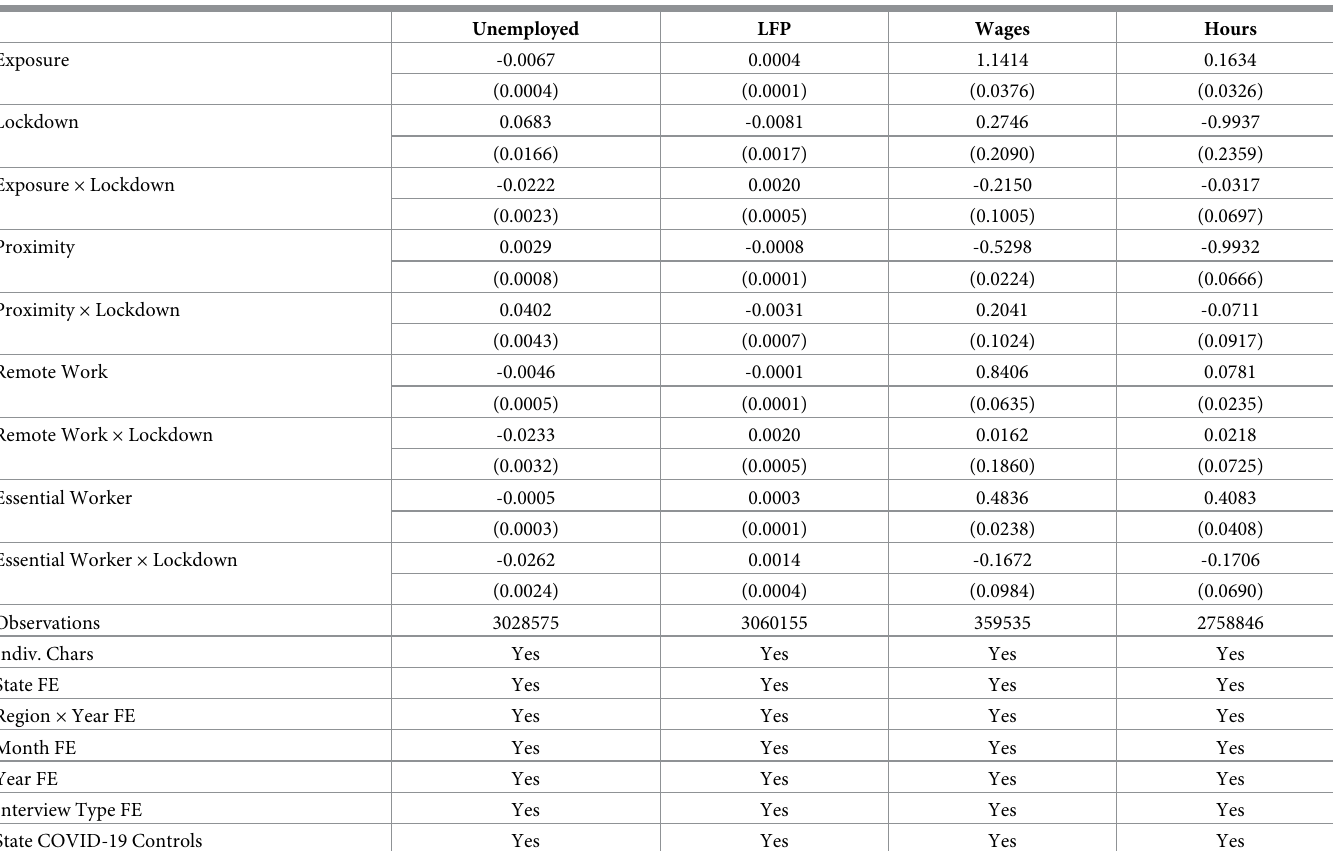
Table 11. The impacts of lockdowns: Exposure, proximity, remote work and essential